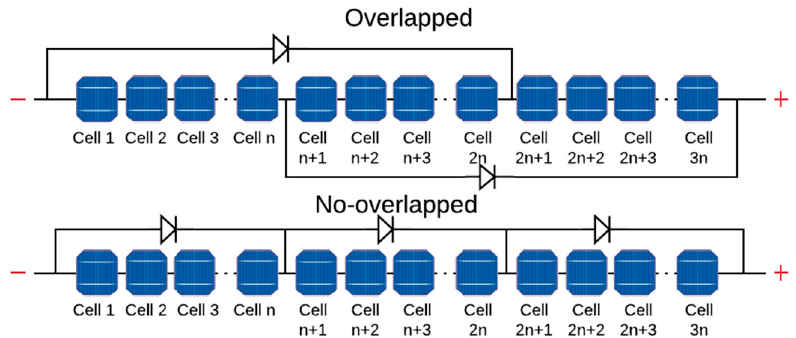
Figure 5. Standard BP diode configurations.